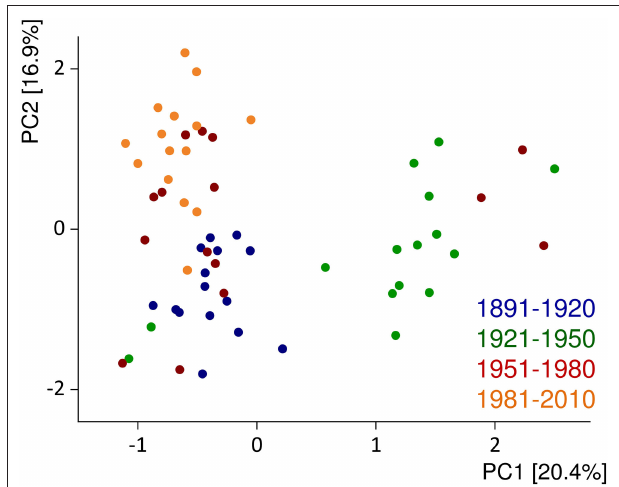
FIGURE 3 | Principal component (PC) analysis biplot of protein fingerprints of albumins/globulins, gliadins, and glutenins relative to the sum of extractable proteins. The data are displayed for 60 German winter wheat cultivars first registered from 1891 to 2010 and show the average of three harvest years (2015–2017). Figure modified from Pronin et al.